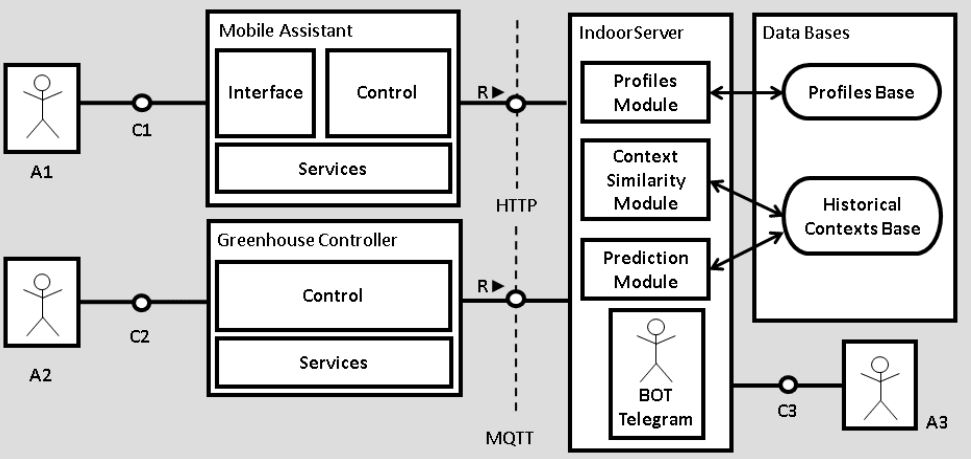
Figure 1. IndoorPlant architecture.